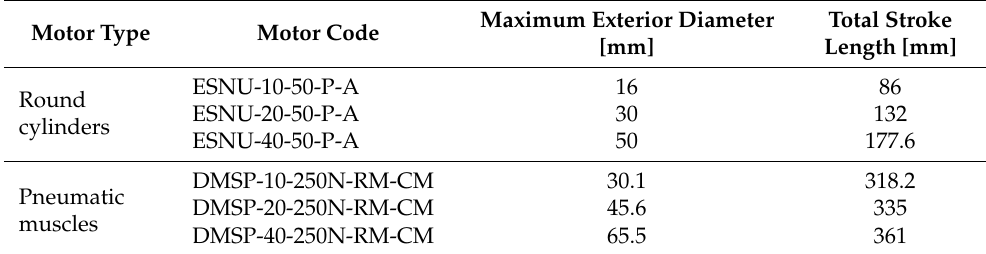
Table 2. Dimensions of the studied pneumatic motors.